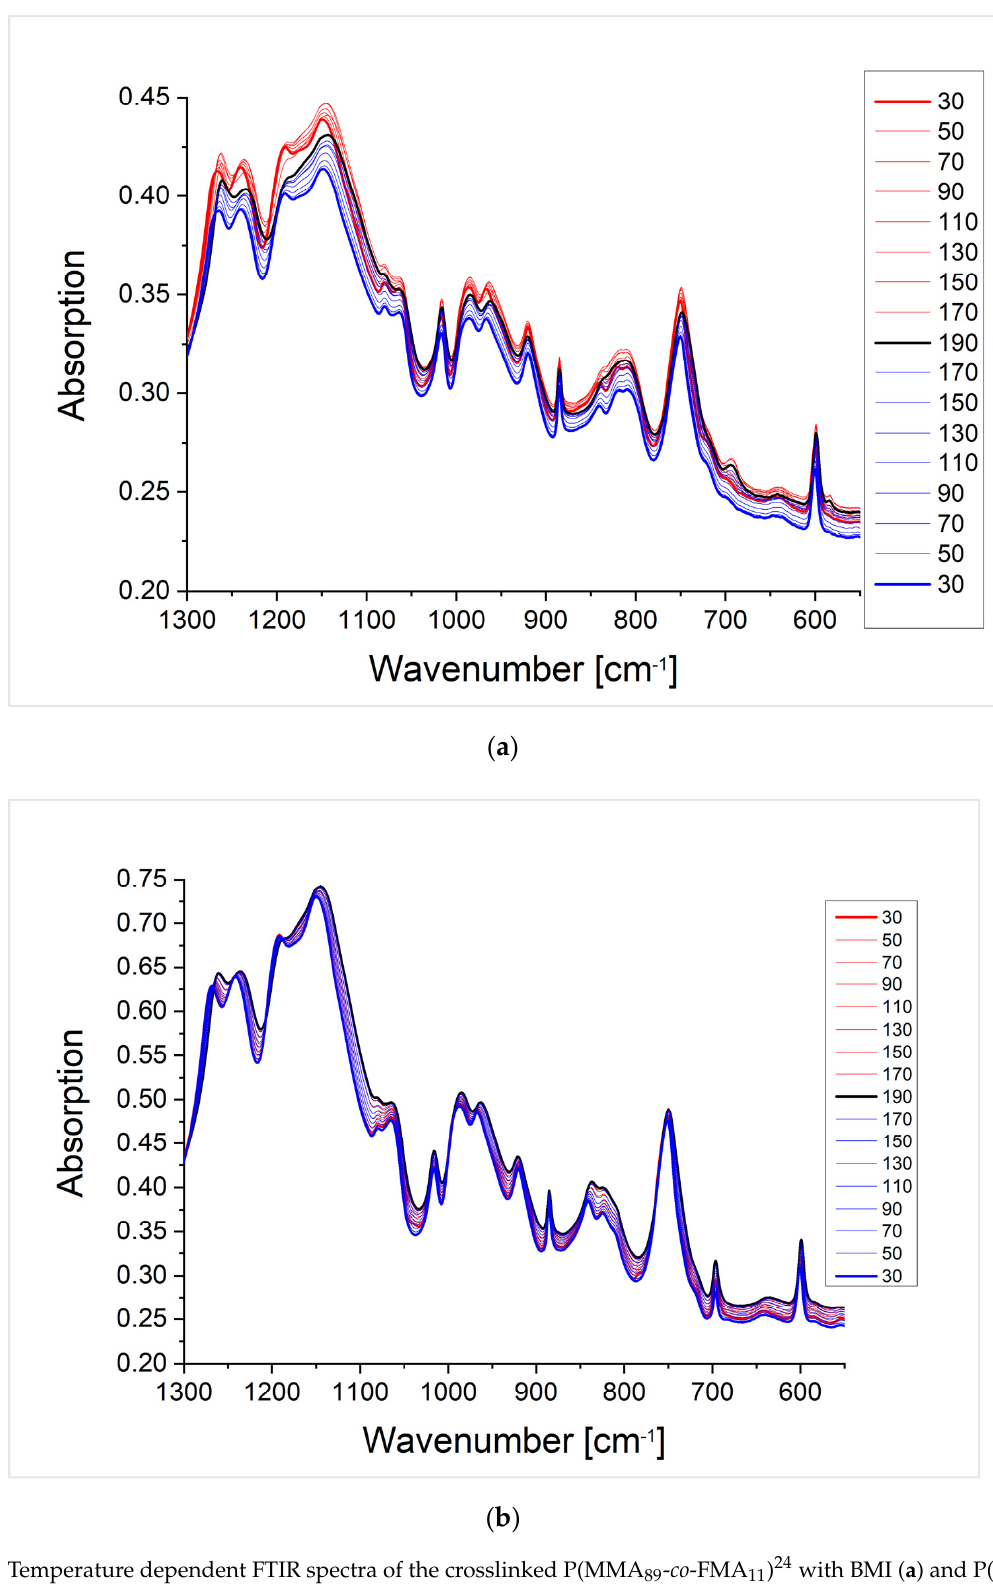
Figure 12. Temperature dependent FTIR spectra of the crosslinked P(MMA 89 - co -FMA 11 ) 24 with BMI ( a ) and P(MMA 74 - co -MIMA 26 ) 9 ( b ). Spectra of the heating cycle (red), spectrum of the maximum temperature (black), and spectra of the cooling cycle (blue). The entire temperature cycle from 30-190-30 °C is shown in the wavenumber range from 1300 to 550 cm − 1 , as, here, the ring deformation mode of the maleimide ring formed in the retro-Diels-Alder reaction can be observed. The crosslinked polymer systems where the glass transition temperature is below (Figure 9 P(BA 60 - co -FMA 40 ) 10 ) or near the Diels-Alder reaction temperature (Figures S35– S39 in the SI; PFMA 5 ), show the dissociation of the network by the retro-Diels-Alder reac- tion, which is indicated by an endothermic peak in all heating curves of the DSC meas- urements. The DSC measurements of P(BA 60 - co -FMA 40 ) 10 crosslinked with BMI or